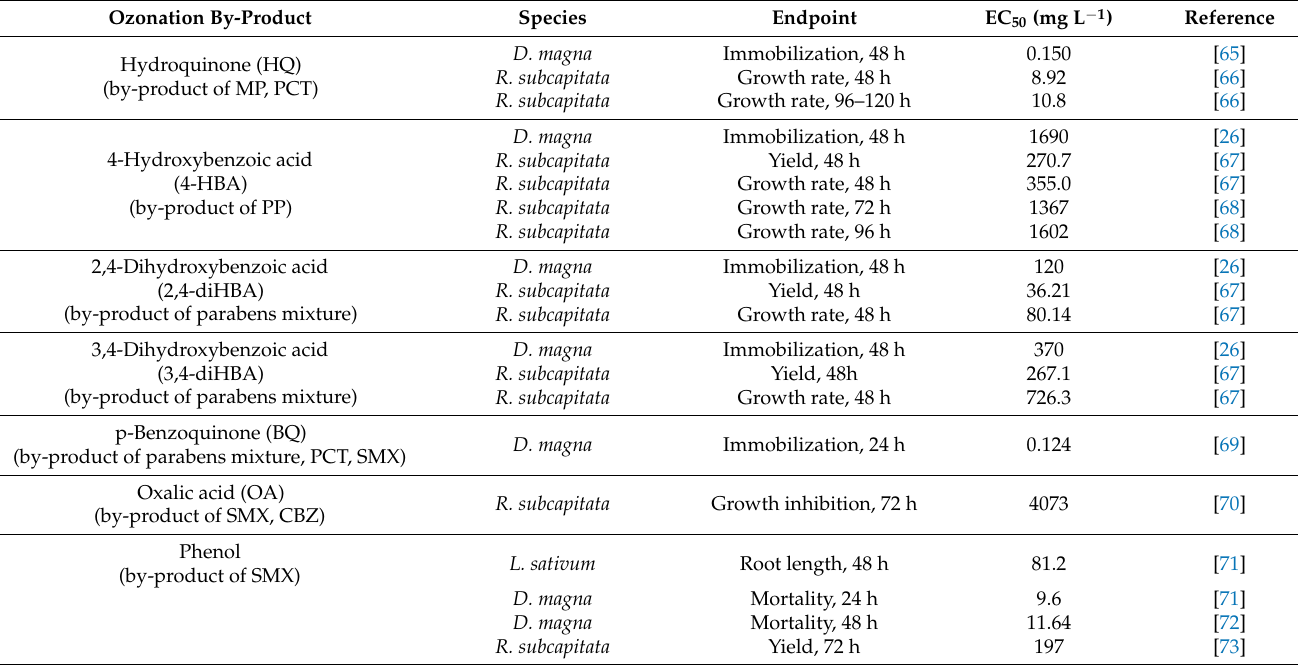
Table 4. Summary of the reference median effective concentrations (EC 50 ) for the reported ozonation by-products of each of the tested PPCPs, estimated on the basis of toxicity tests following similar protocols to those carried out in the present study with R. subcapitata , D. magna , L. minor , and L. sativum